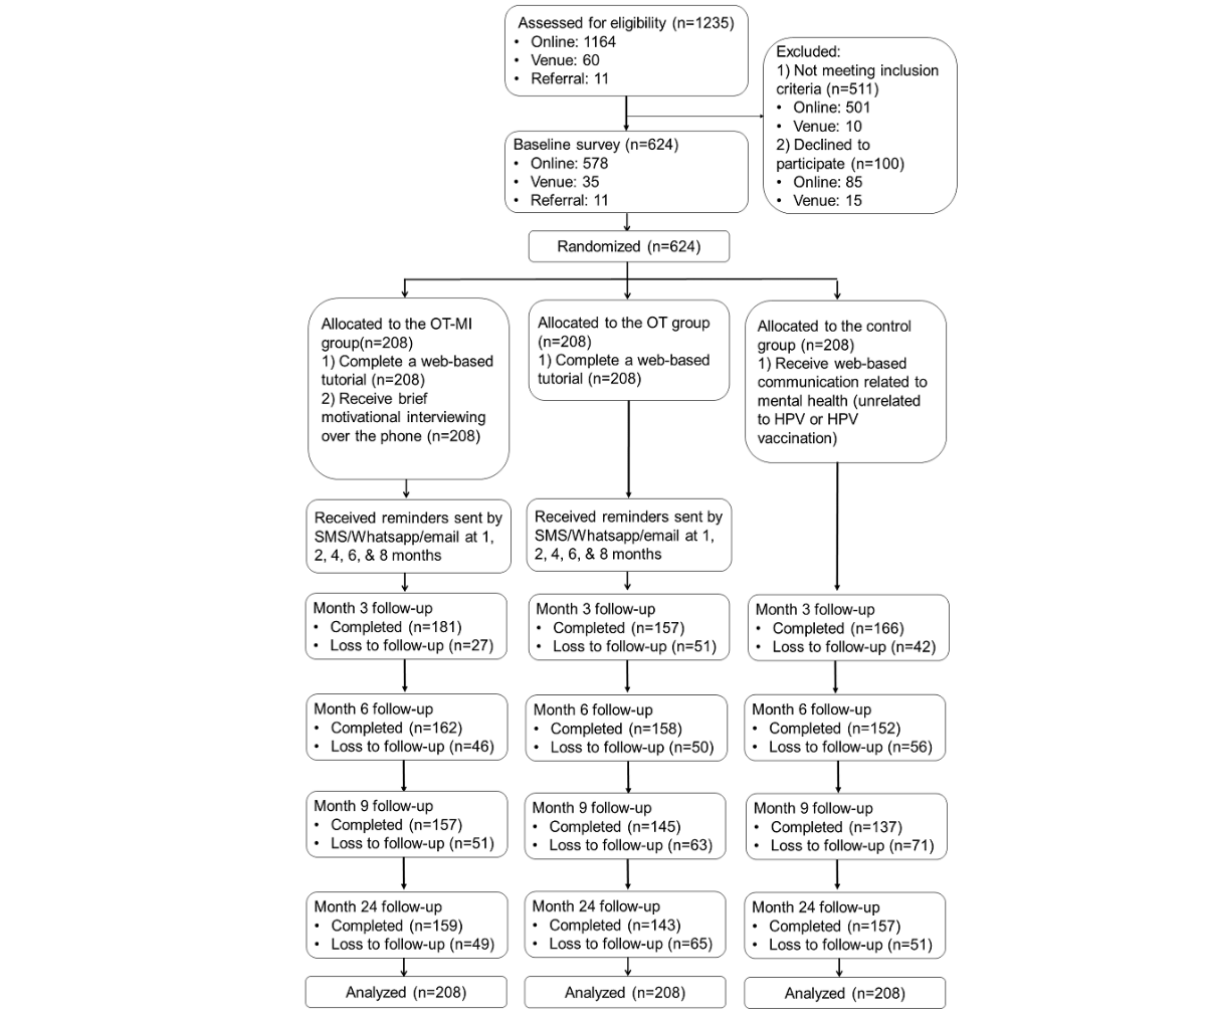
Figure 1. CONSORT (Consolidated Standards of Reporting Trials) flow diagram of the